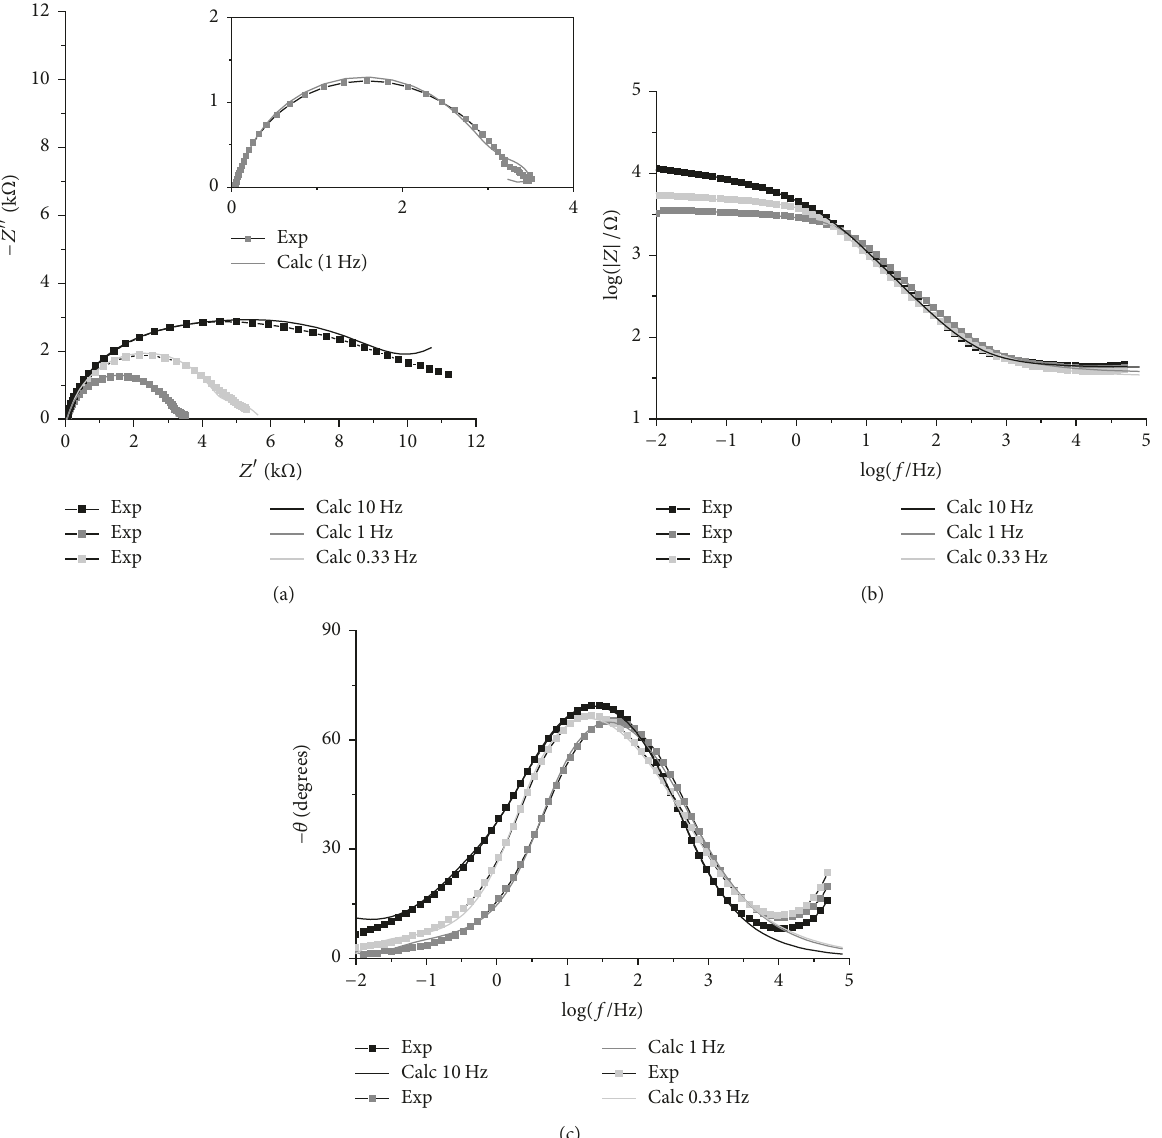
Figure 6: EIS spectra obtained in Nyquist format for nonelectropolished titanium surfaces after anodisation at different pulsed current frequencies in 0.9% NaCl solution. Calculated (Calc) values are represented by a solid line, which were obtained by data fitting through the equivalent circuit model of Figure 7(a).